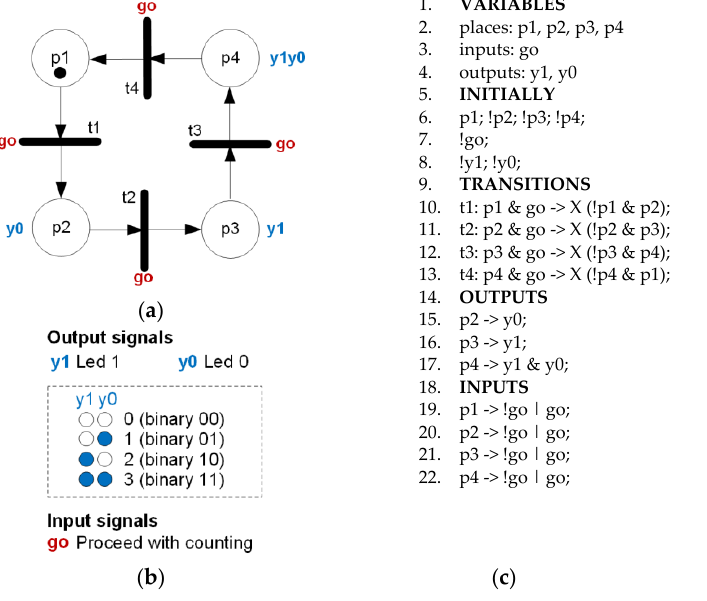
Figure 1. A sample interpreted Petri net ( a ), description of signals ( b ), and the rule-based logical model ( c ).